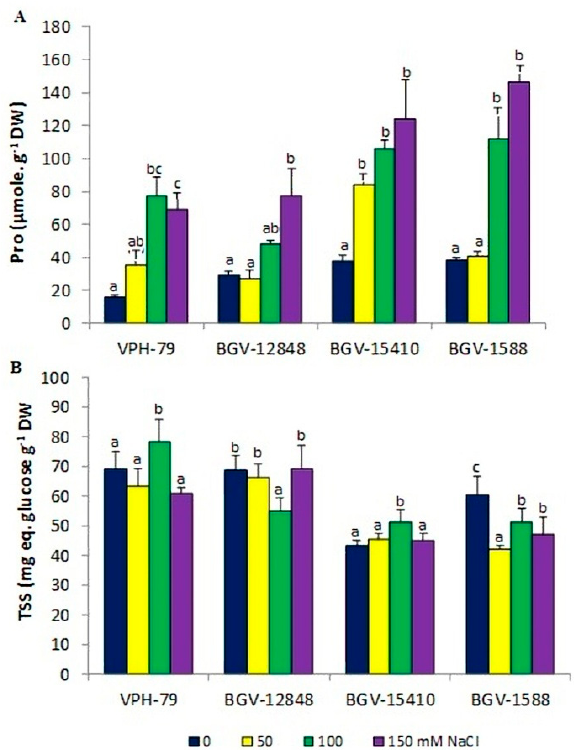
Figure 2. Leaf osmolyte concentrations in plants of the four Phaseolus lunatus cultivars, grown for three weeks in the presence of the indicated NaCl concentration. Proline (Pro) ( A ) and total soluble sugar (TSS) concentrations ( B ). Means followed by SE ( n = 5). Different letters indicate significant differences within each cultivar according to Tukey’s test ( α = 0.05).